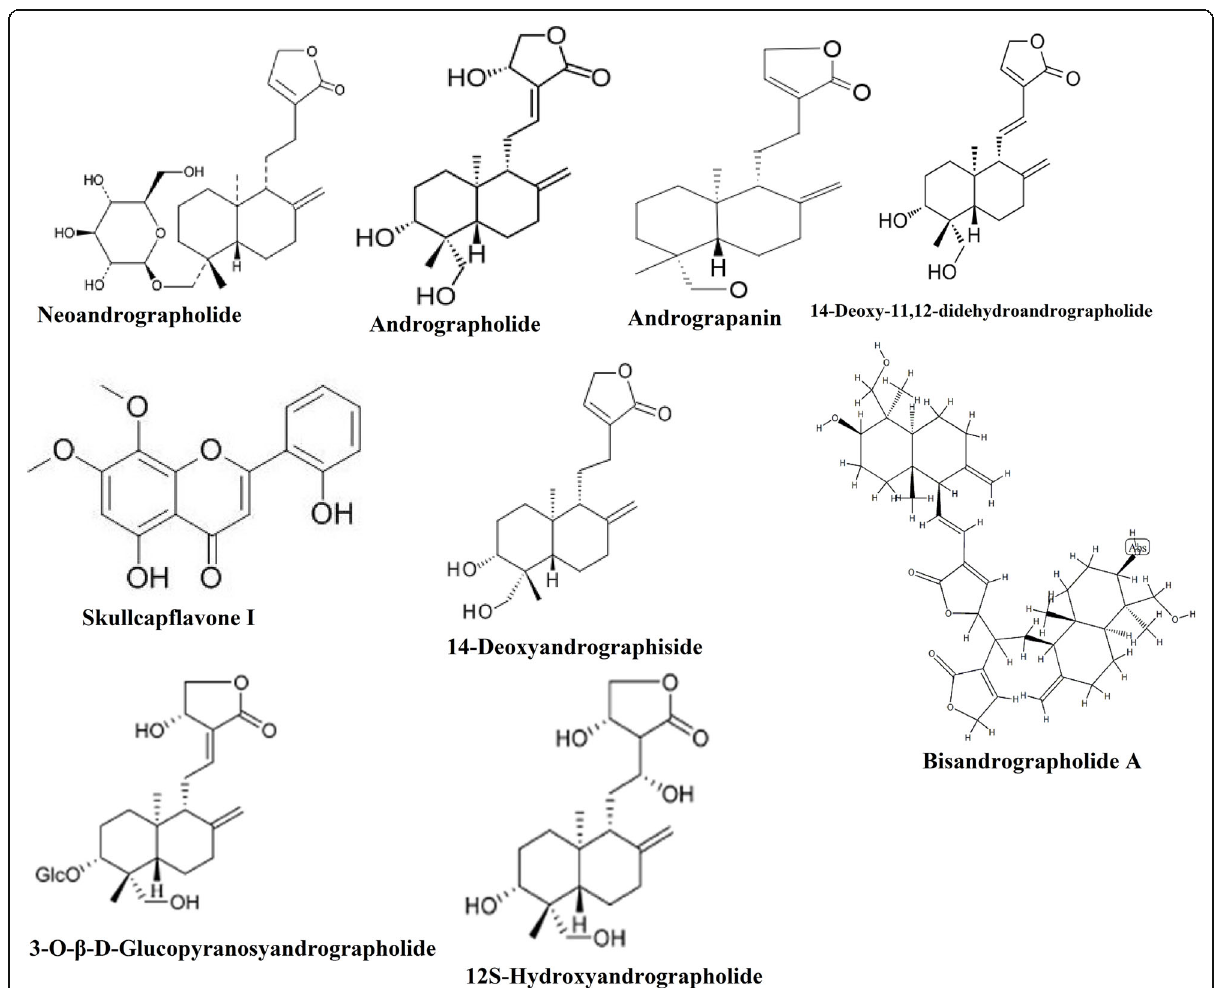
Fig. 7 Structure of some essential Diterpenoids identified by LC-MS